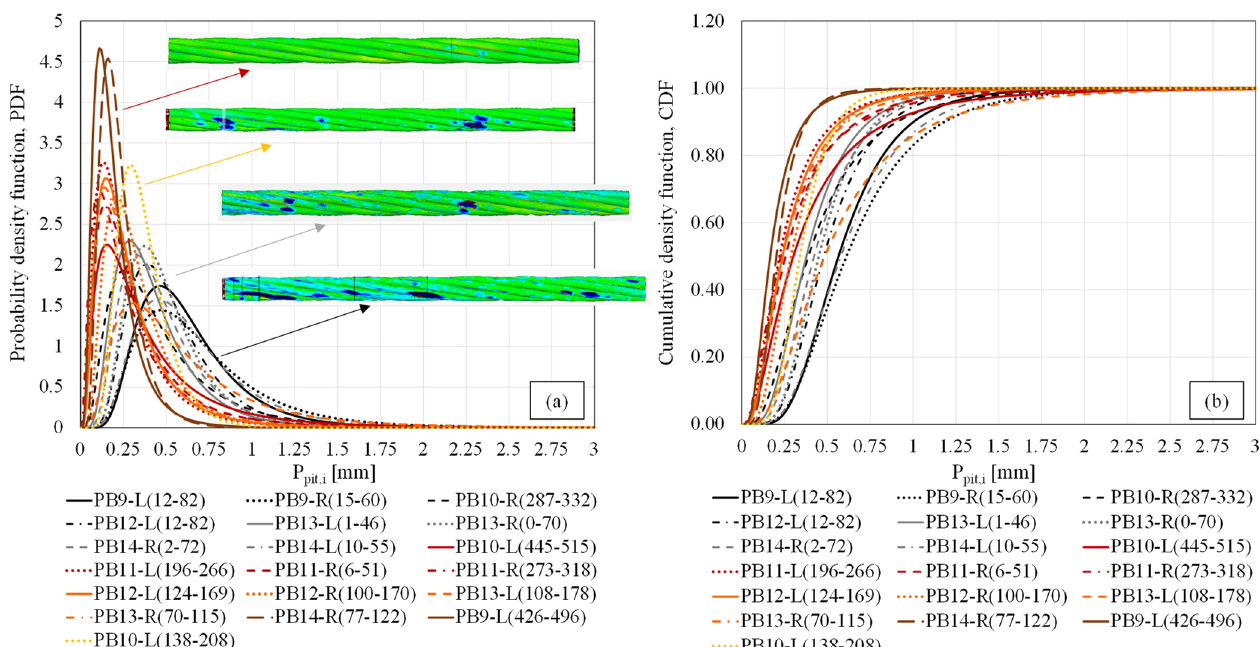
Figure 6. Probabilistic distribution functions of penetration depth of each corroded prestressing strand: ( a ) PDF and ( b ) CDF.